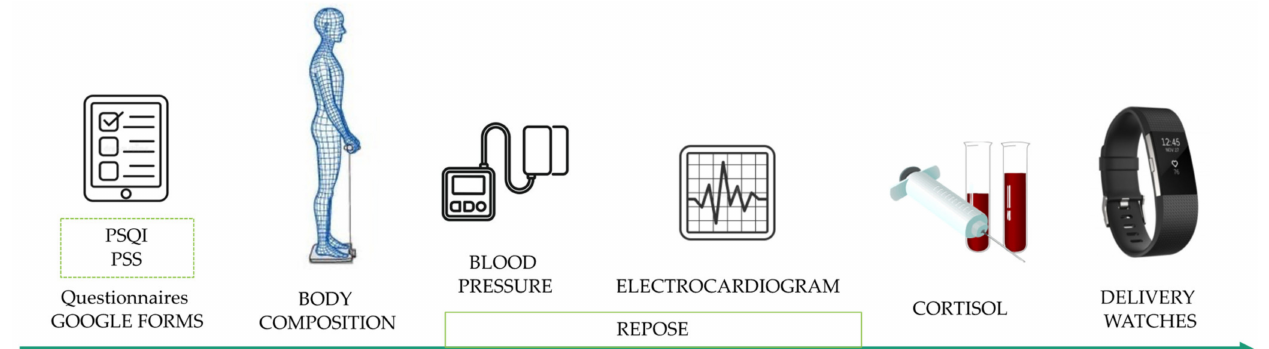
Figure 4. Development of the visits. PSS = perceived stress scale; PSQI = Pittsburgh sleep quality